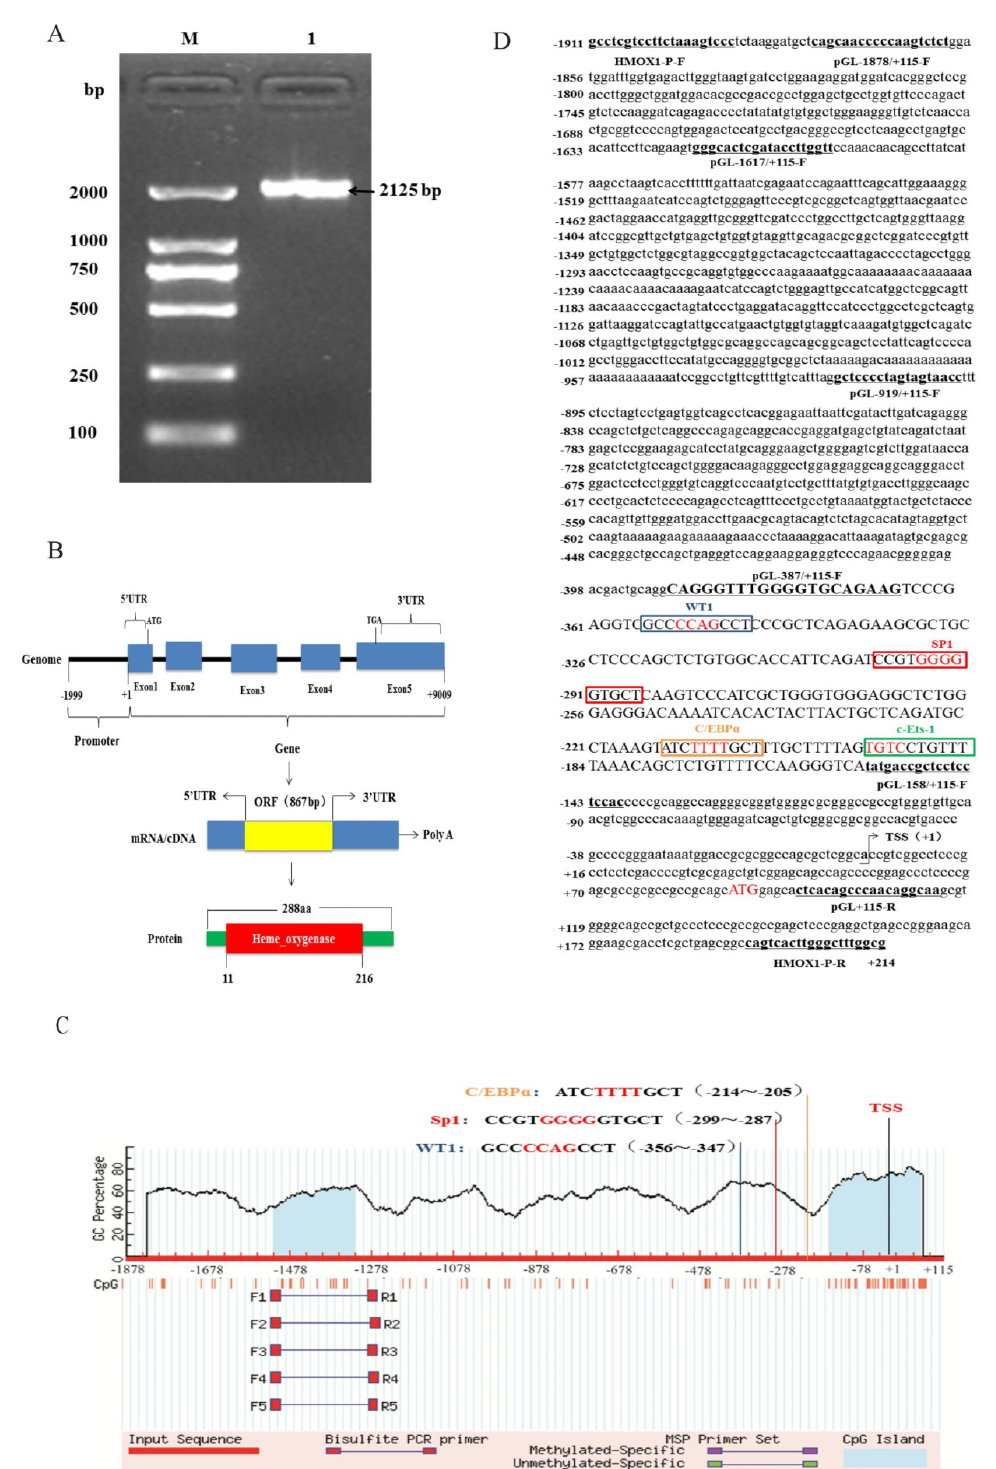
Figure 2. Promoter region cloning and bioinformatics analysis. ( A ) PCR amplification product of HMOX1 gene promoter region. M, DL2000 DNA marker; 1, PCR product. ( B ) Genomic structure of HMOX1 gene. ( C ) The predict results of CpG island in HMOX1 gene. ( D ) The promoter sequence information of HMOX1 gene. The box represents the transcription factor binding sites, and the 4 bp core binding sites are shown in red. The underline represents the amplification primer and the arrow represents the transcription start site